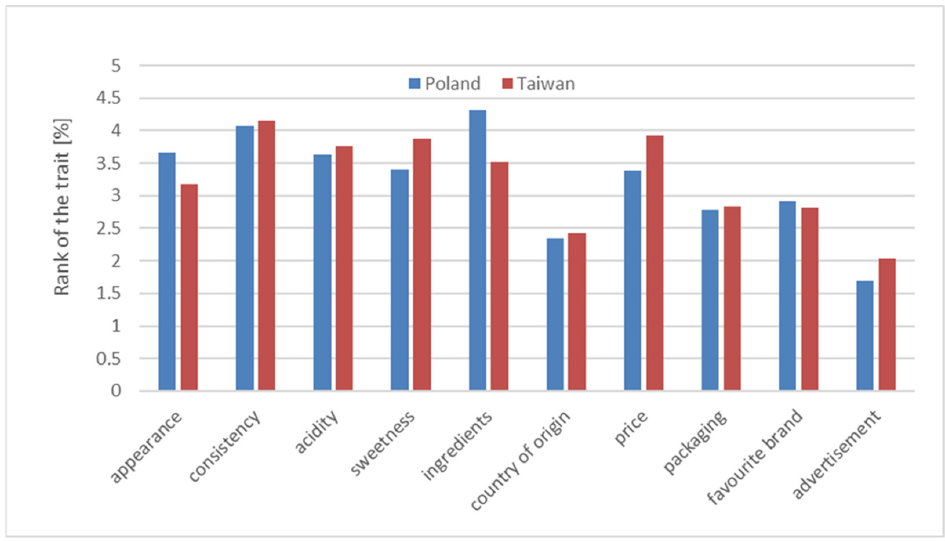
Figure 3. Characteristic of yoghurt influencing the purchase decision of Polish and Taiwanese consumers: scale of 1–5, where 5 is most important and 1 is least important.